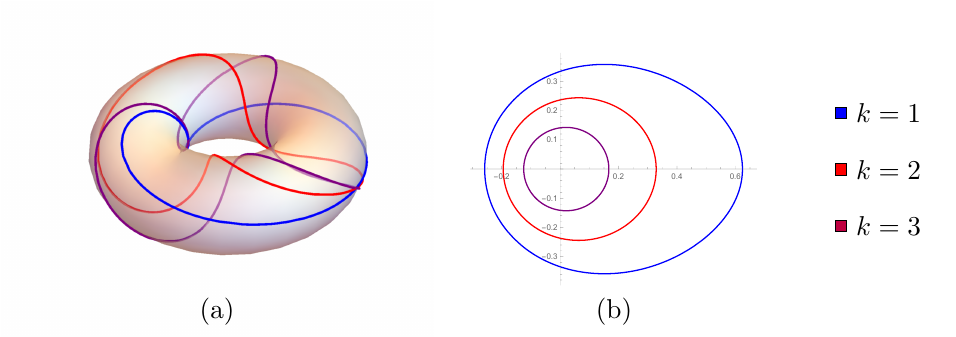
Figure 3 . 1-, 2- and 3-soliton solutions: a) soliton trajectories on torus T with coordinates ( e 2 π i x 1 − 2 π i Y I ) , b) soliton trajectories on complex e − 2 π Y L , e